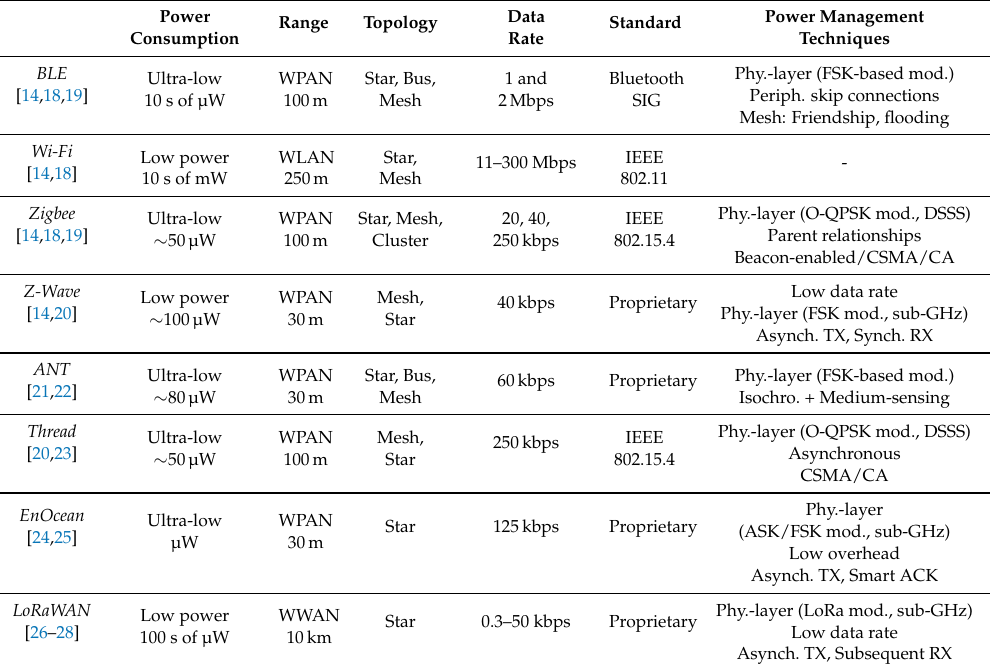
Table 1. Most common ultra-/low power